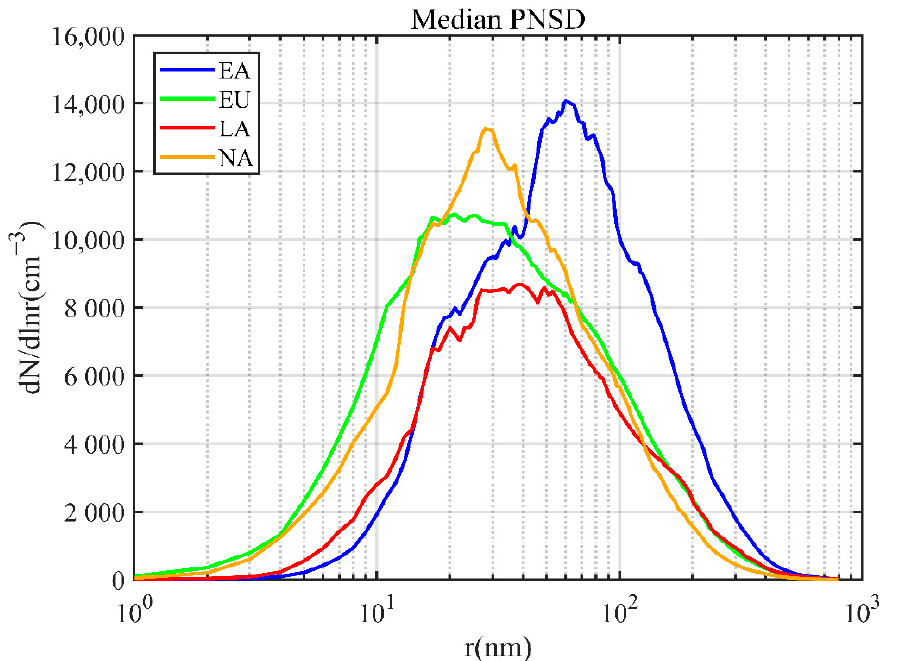
Figure 1. Representative PNSDs in different regions. The representative samples of the four regions in the figure are the median value of the PNSD.